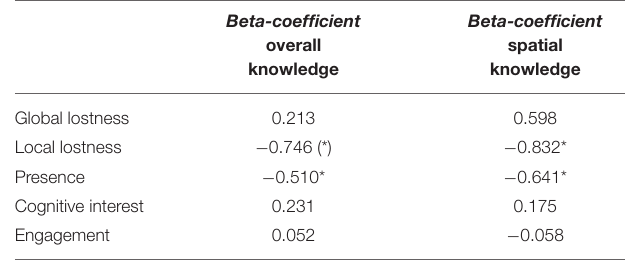
TABLE 4 | Beta-coefficients between knowledge, lostness, and experience measures from the first